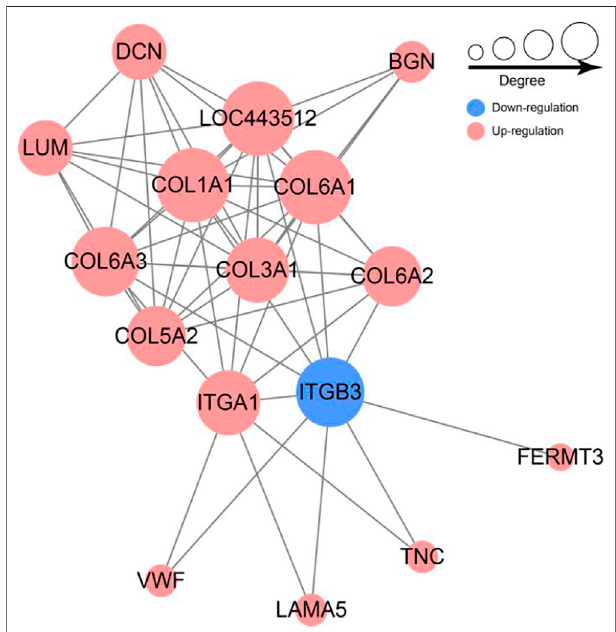
FIGURE 6 | Network of differentially expressed protein involved in ECM- receptor interaction and PI3K-Akt signal pathway.